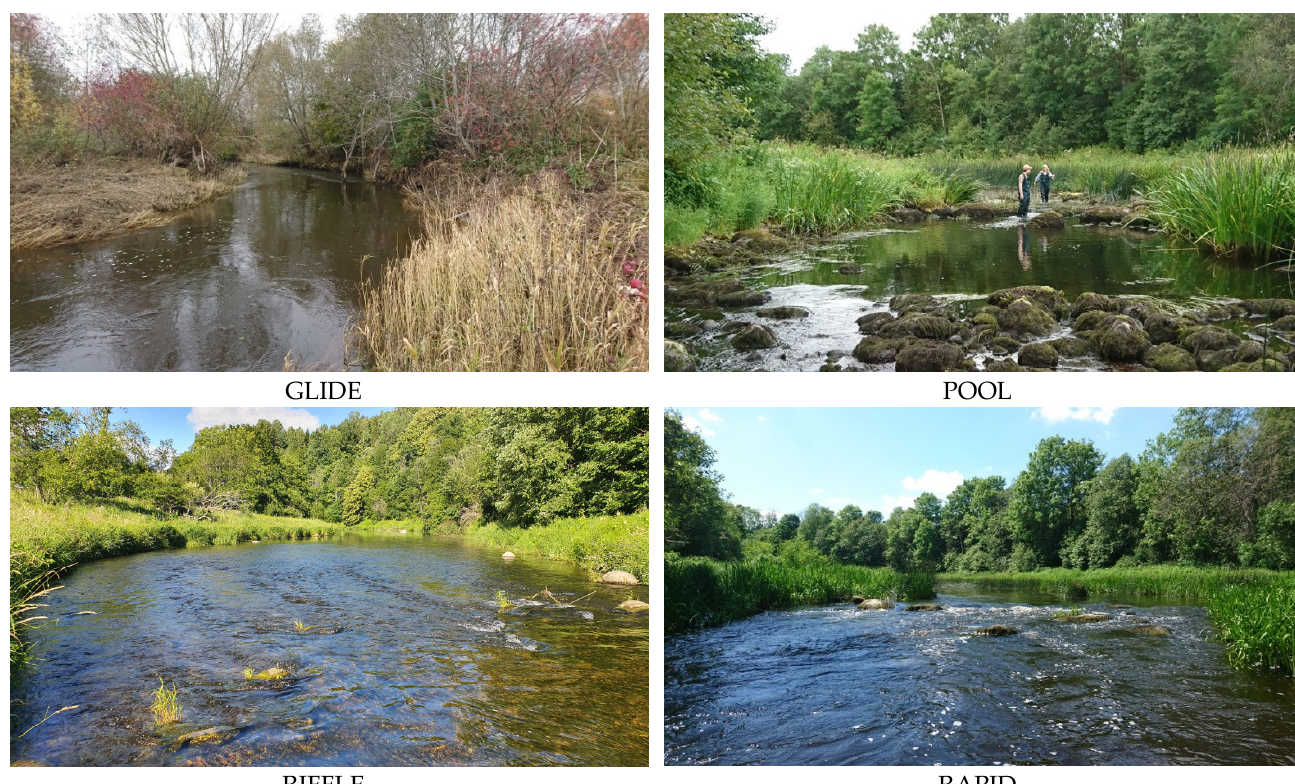
Figure 3. Examples of the most common HMUs in studied river stretches (photos by Vytautas Aksti- nas).